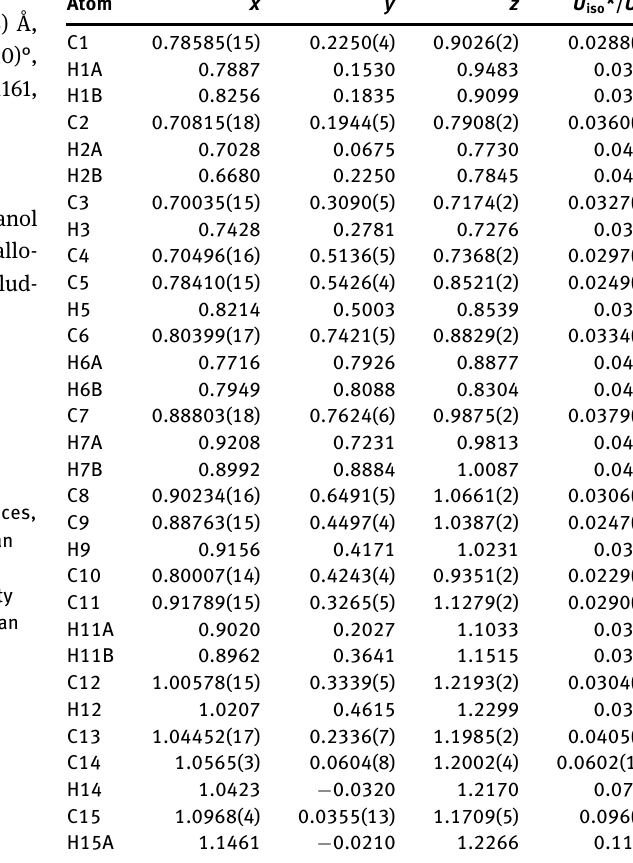
Table 2: Fractional atomic coordinates and isotropic or equivalent isotropic displacement parameters (Å 2